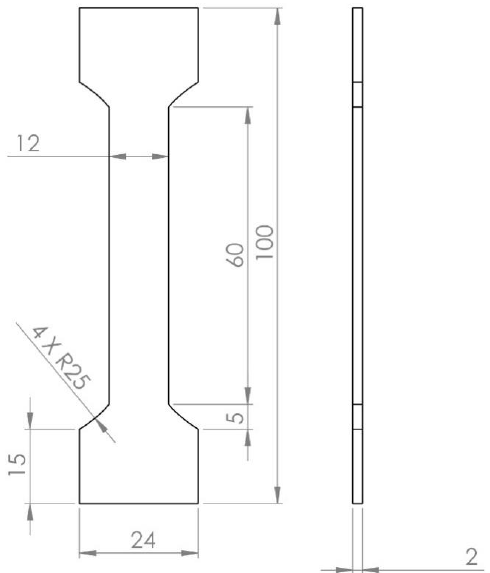
Figure 15. A schematic of the tensile test specimen.